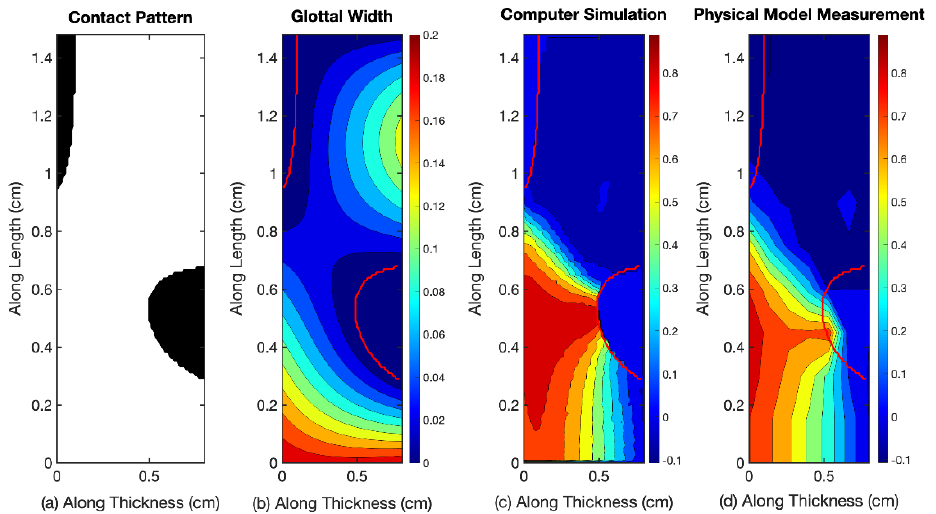
Figure 7. Four variables depicted in a rectangular glottis with inferior (left), superior (right), posterior (bottom) and anterior (top) boundaries. ( a ) vocal fold contact regions, ( b ) glottal width, ( c ) calculated surface pressure with high-dimensional computation, and ( d ) measured pressure with an up-scaled static model [26].